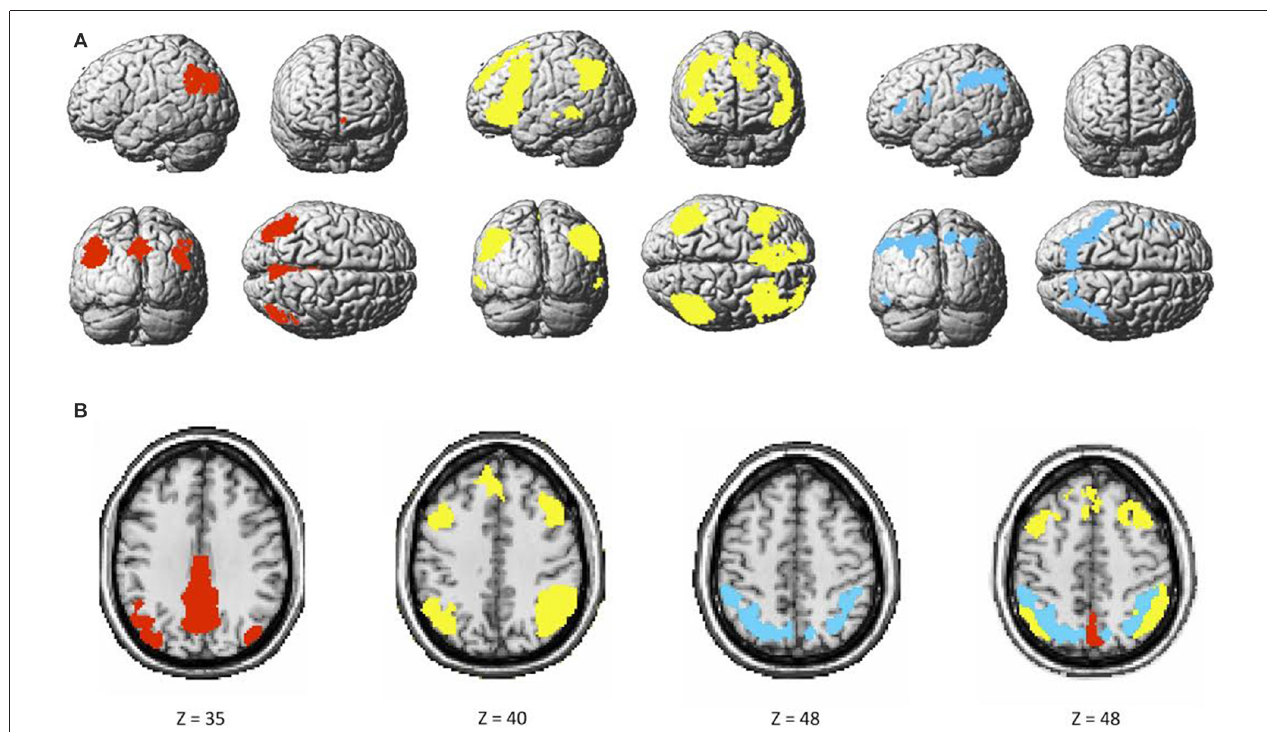
FIGURE 3 | (A) Maps of the default mode (DMN; red), bilateral frontoparietal control (FPN; yellow), and dorsal attention (DAN; blue), and (B) overlap among the three networks.